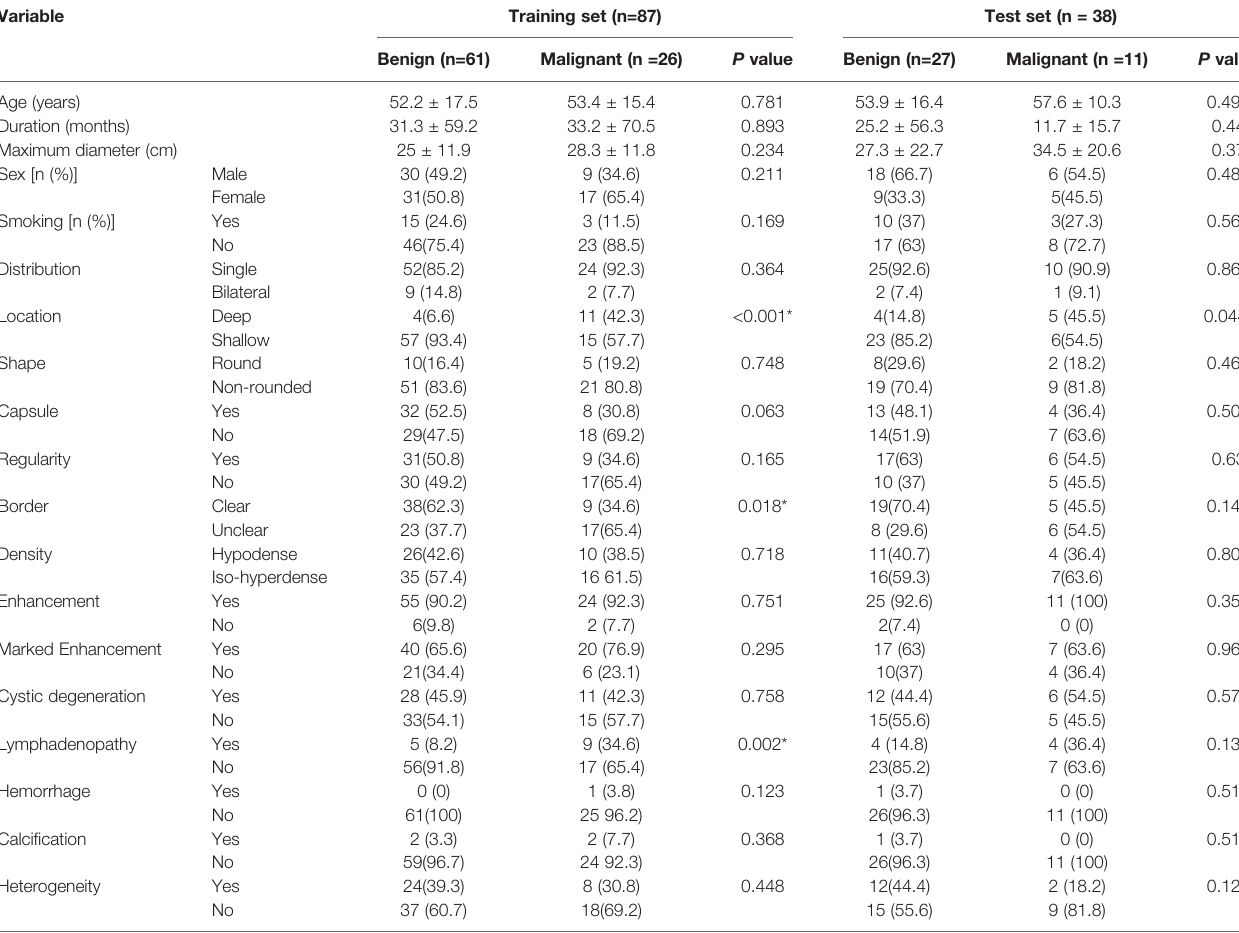
TABLE 3 | Clinical and radiological characteristics between benign and malignant parotid gland tumors in the training and test sets. Variable